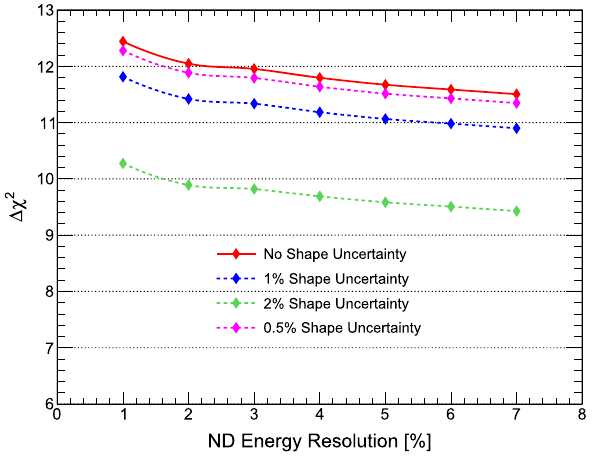
Fig. 9 SensitivityofMHresolutionastheenergyresolutionofthenear detectorincreasesandfordifferentdetectoruncertaintyofND.Thenear detector provides the reference spectrum, which is smoothed according to the energy resolution of the ND. Similar to our previous simulations based on the Daya Bay measurement in Sect. 3, the detector